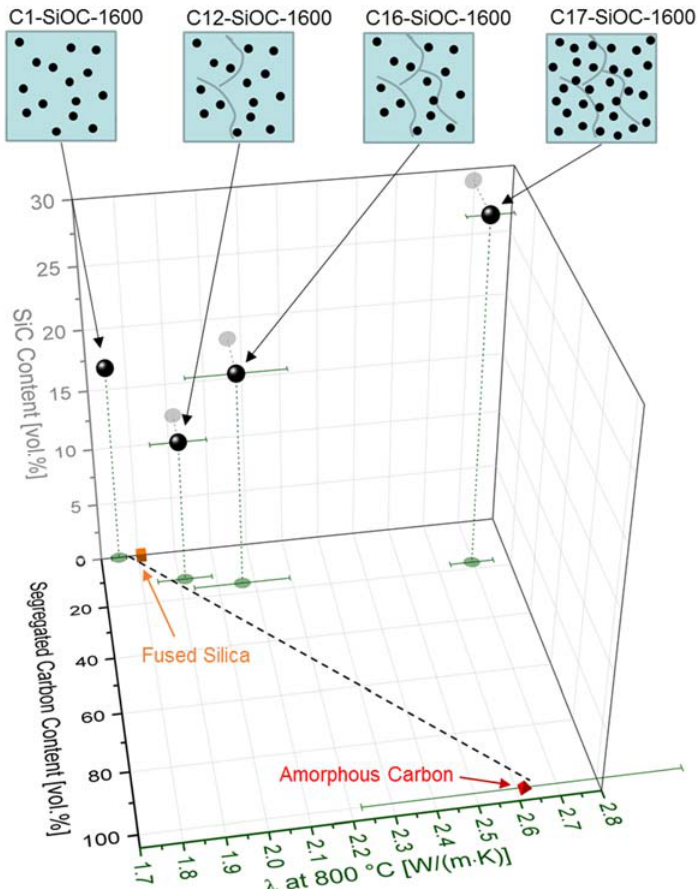
Figure 8. Thermal conductivity λ of the SiOC glass ceramics investigated in this work, and of reference materials at 800 ◦ C, as a function of the segregated carbon content and the SiC content. Data for fused silica was extrapolated from Cahill [52], and data for amorphous carbon was taken from Ho et al. [53]. Two-dimensional (2D) projections of the individual values on the xy plane and on the yz plane are included as green and grey transparent dots, respectively. Sample C1–SiOC–1600 and sample C12–SiOC–1600 can be effectively described as a linear mixture between the two percolating phases ( cf . trend line), namely, the glassy SiO 2 matrix and the segregated carbon phase. The β -SiC particles possibly show a slight impact for C16–SiOC–1600, and a significant impact for C17–SiOC–1600. They are expected to have a strong contribution to the thermal transport as part of a high- λ percolating phase consisting of segregated carbon and β -SiC. The highly schematic images of the respective microstructures are indicated for SiOC glass ceramics at the top insets, in which the black dots represent β -SiC, and the grey lines represent the segregated carbon phase.